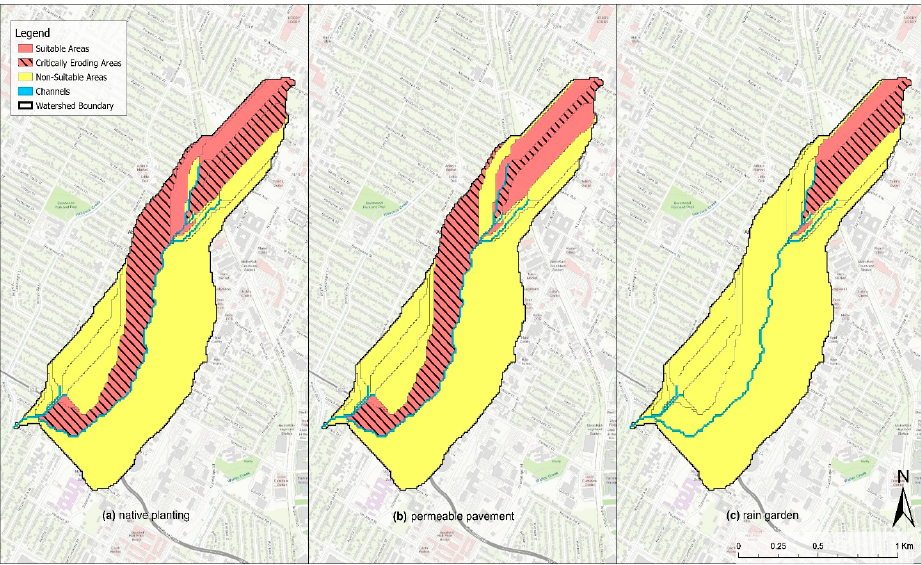
Figure 2. Suitable areas and Critically Eroding Areas (CEAs) for implementation of ( a ) native planting, ( b ) permeable pavement, and ( c ) rain garden. Detention ponds were designed in the